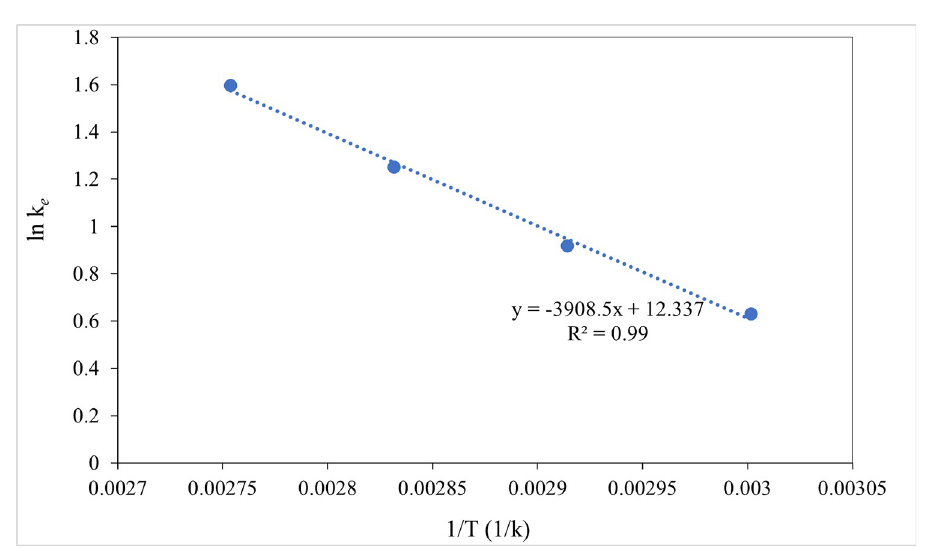
Fig 5. Plot of ln K e against 1/T for EPA extraction process to determine the thermodynamic parameters.